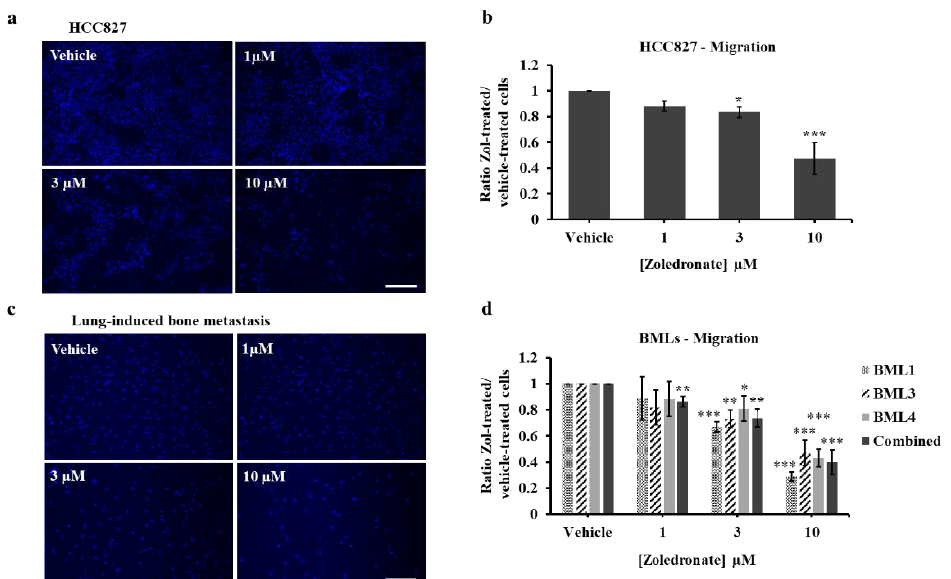
Figure 5. Migration (Transwell chamber cell assay) of HCC827 ( a , b ) and lung cancer-induced bone metastasis cells ( c , d ) treated with vehicle (PBS1x) or Zol 1 µM, 3µM and 10 µM for 7 days in 1% serum conditions. Representative images of HCC827 ( a ) and bone metastasis (BML3) ( c ) cells from vehicle or Zol-treated conditions. Scale bar 100 µM. The histograms represent the ratio of drug-treated cells divided by vehicle-treated cells (PBS1x) for HCC827 ( b ) and bone metastasis ( d ) cells. Results are the mean ± SD of three independent experiments for HCC827 and bone metastasis cells. Significantly different from control * p < 0.05, ** p < 0.01 and *** p < 0.001.